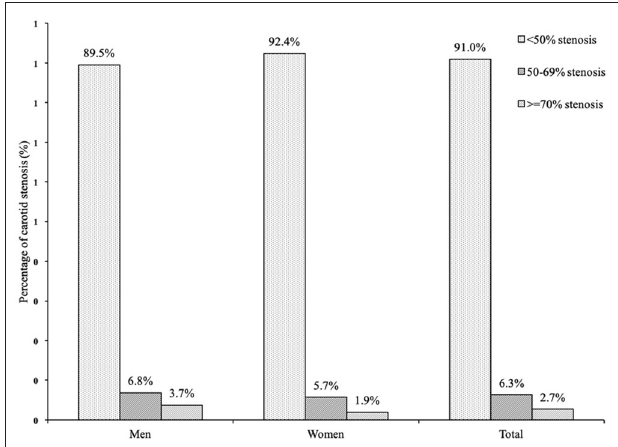
FIGURE 2 | The distribution of carotid stenosis in the population with carotid plaque in rural northeast China.